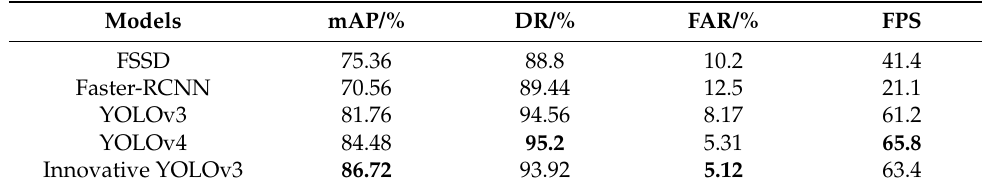
Table 6. Detection effects of the different